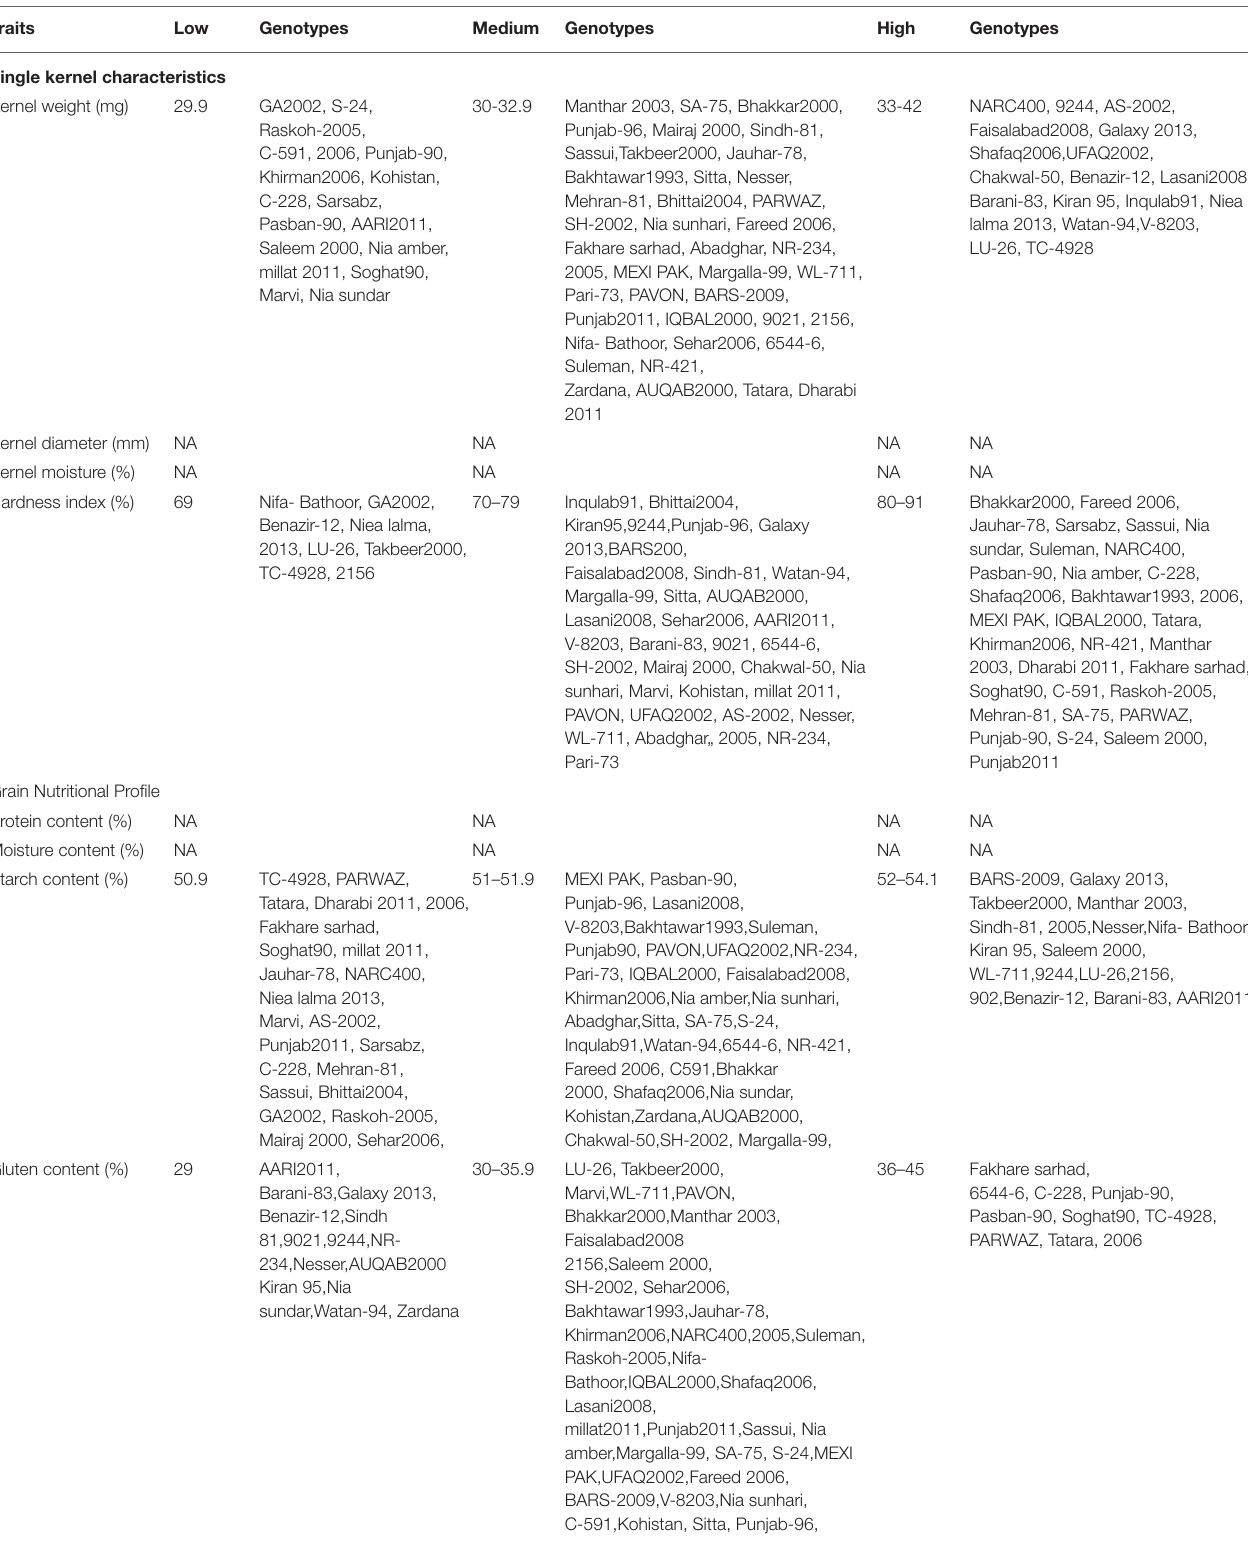
TABLE 1 | Scale for categorization of wheat genotypes in low, medium, and high value for different quality attributes. Traits Low Genotypes Medium Genotypes High